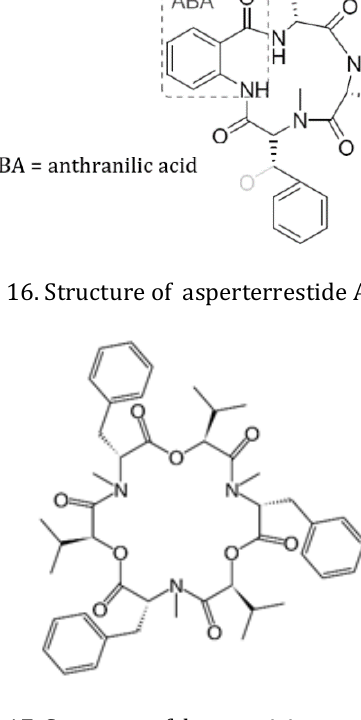
Figure 15. Structure of asperterrestide A